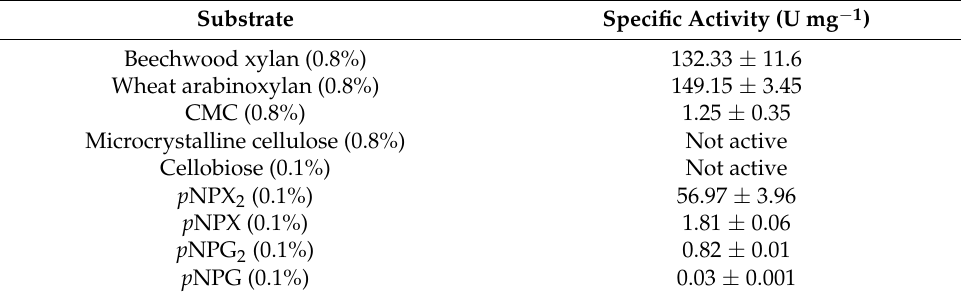
Table 1. Endoxylanase-specific activities of rXynSOS against different substrates.